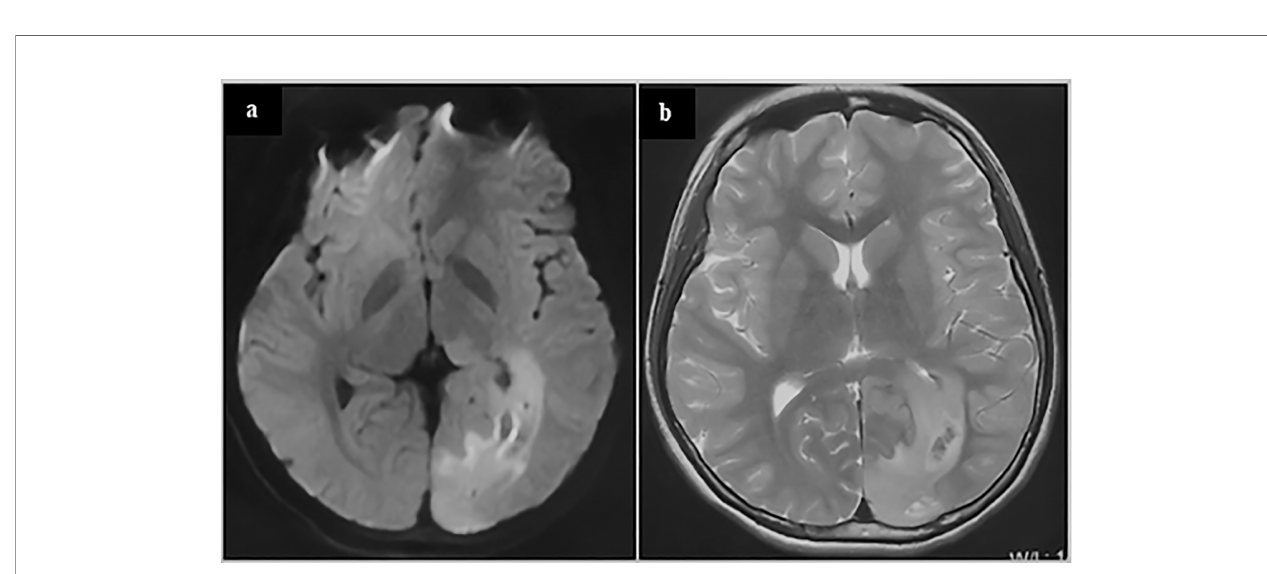
FIGURE 3 | The relationship between the mutation of neural stem cells in the subependymal zone and the occurrence of multicentric glioma. The rectangular box on the left shows the normal subependymal area that is not affected by the tumor, and the oval area on the left shows the normal microstructure of the subependymal area. From the ventricle to the brain parenchyma, there are ependymal layer (layer 1), gap zone (layer 2), astrocyte zone (layer 3), loose layer (layer 4), and brain parenchyma (layer 5). It can be seen that neural stem cells differentiate into less primary progenitor cells, and the local cell hierarchy is regular. The rectangular frame on the right shows the location of the mutant neural stem cells, and the oval area on the right shows the microstructure of the area. As shown in the fi gure, early gene mutations occurred in neural stem cells in this area, leading to active cell proliferation and differentiation into progenitor cells. The primary progenitor cells migrated along the white matter fi bers and blood vessels into the brain parenchyma, replicated, differentiated, and accumulated mutations to form tumors. The arrow shows the migration pathway of the mutant progenitor cells: the green arrow shows the migration into the brain parenchyma, the red arrow shows the local migration along the subependymal zone, and the blue arrow shows the migration along the cerebrospinal fl uid (to be veri fi ed). (Yellow cells in layer 1, ependymal cells; blue cells in layer 2, neural stem cells; pink cells in layer 3, progenitor cells; brown-yellow cords in layer 3 and layer 4, axons and synapses of distant neurons; green dots, chemical transmitters in cerebrospinal fl uid).